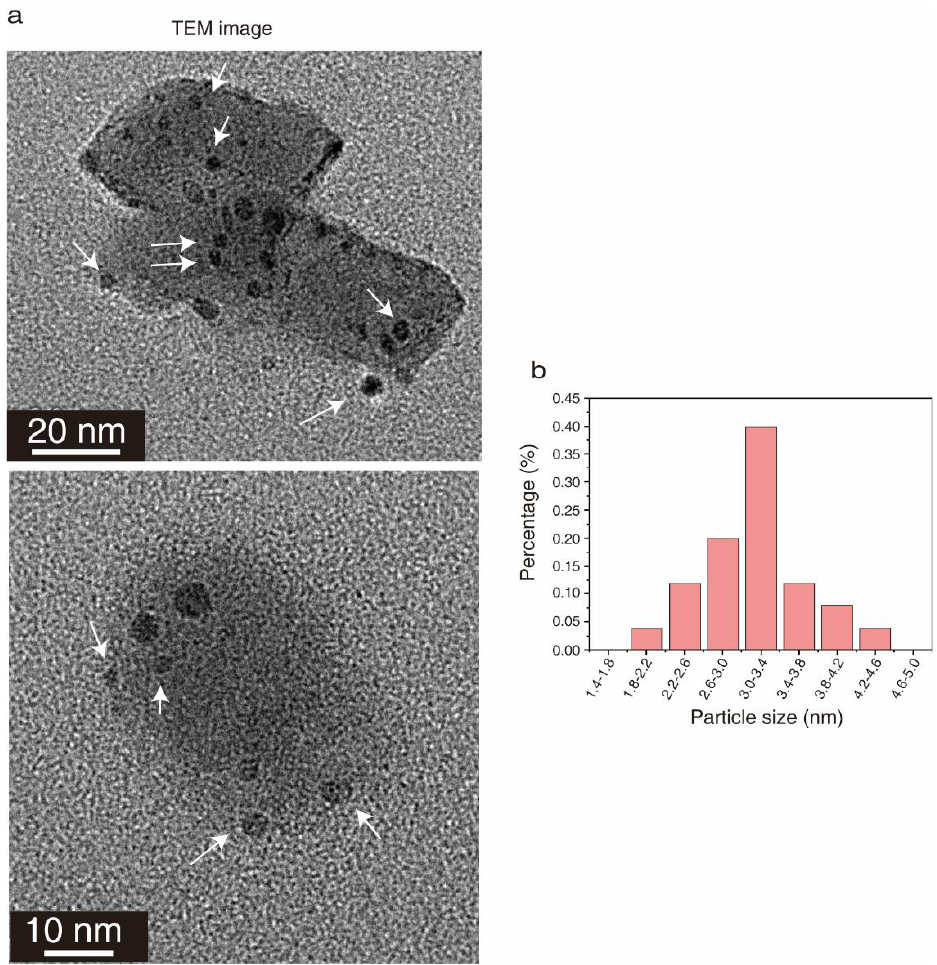
Figure 2. The shape and size of CQDs prepared from waste chicken bones. ( a ) TEM image of CQDs. The arrows indicated the prepared CQDs. ( b ) Size distribution of CQDs.